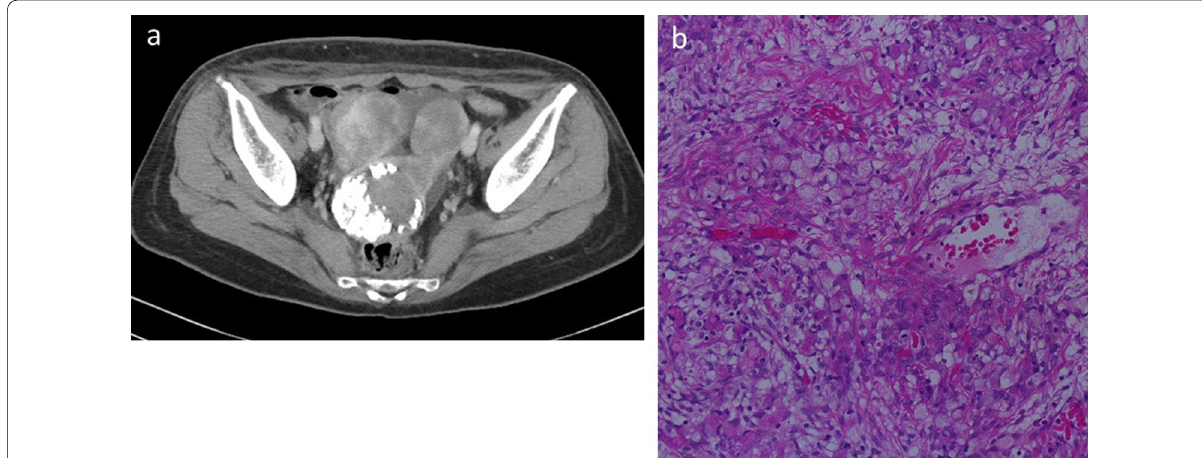
Fig. 2 Computed tomography (CT) and pathological findings in the ovary. a Abdominal CT showed bilateral ovarian enlargement with uterine calcification due to myoma. b Pathological findings revealed signet-ring cells and a poorly differentiated adenocarcinoma (